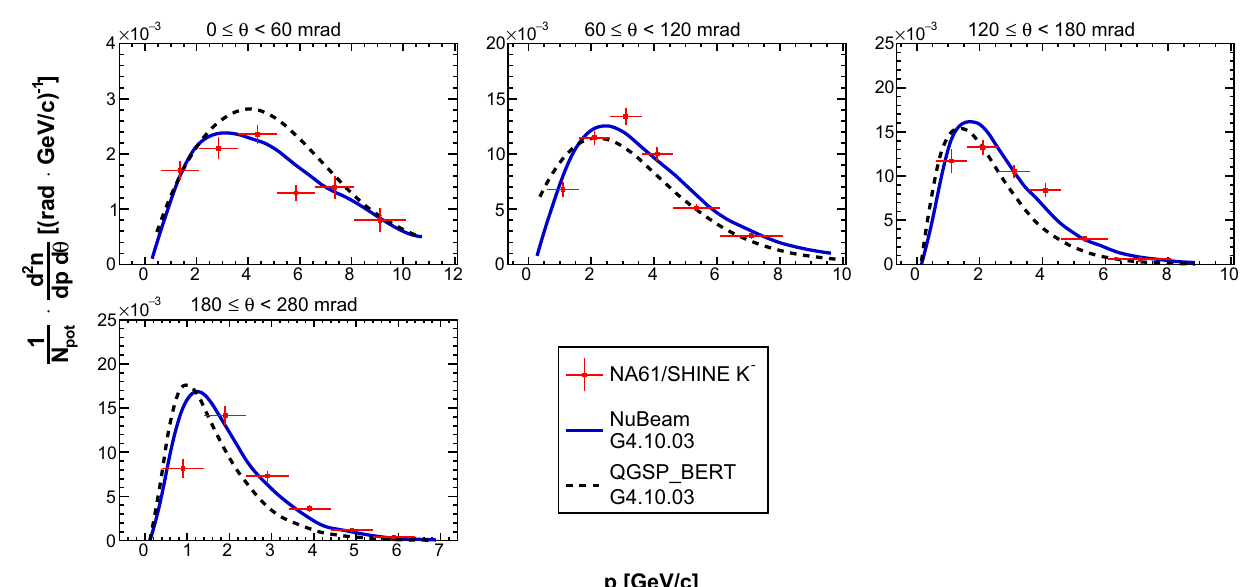
Fig. 42 Double differential yields of negatively charged kaons for the second upstream longitudinal bin (18 ≤ z < 36 cm). Vertical bars represent the total uncertanties. Predictions from the NuBeam (solid